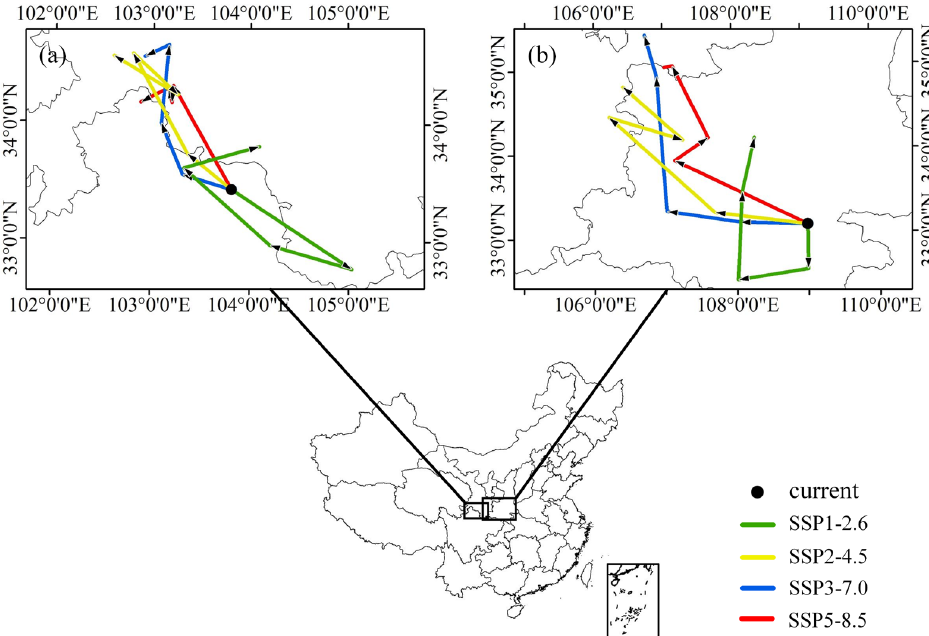
Figure 6. Distributional centroid shifts of suitable areas for ( a ) MEAM1 and ( b ) MED cryptic species of the Bemisia tabaci species complex in China in different periods (2030s, 2050s, 2070s, and 2090s) under four future climate change scenarios. SSP, shared socioeconomic pathway.